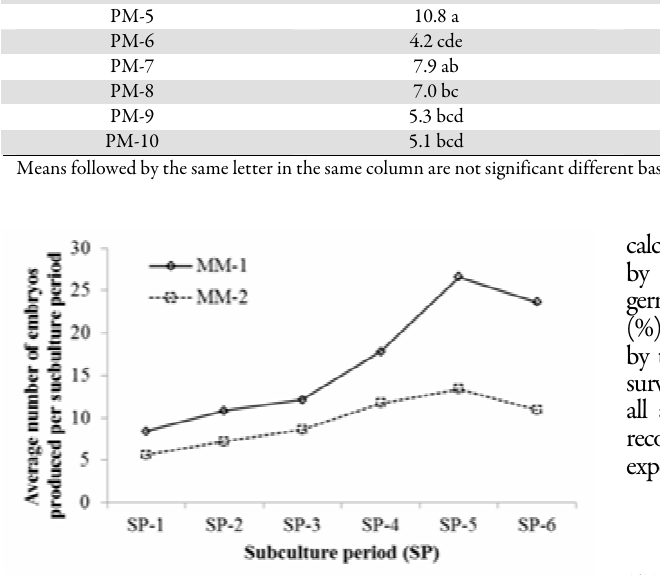
Fig. 3. Development pattern of secondary embryos produced gradually in each subculture period in two selected-media of MM-1 and MM-2 MM-1, half-strength MS medium supplemented with 0.13 mg/L TDZ and 0.25 mg/L BAP; MM-2, half-strength MS medium with full strength of vitamin containing 150 ml/L